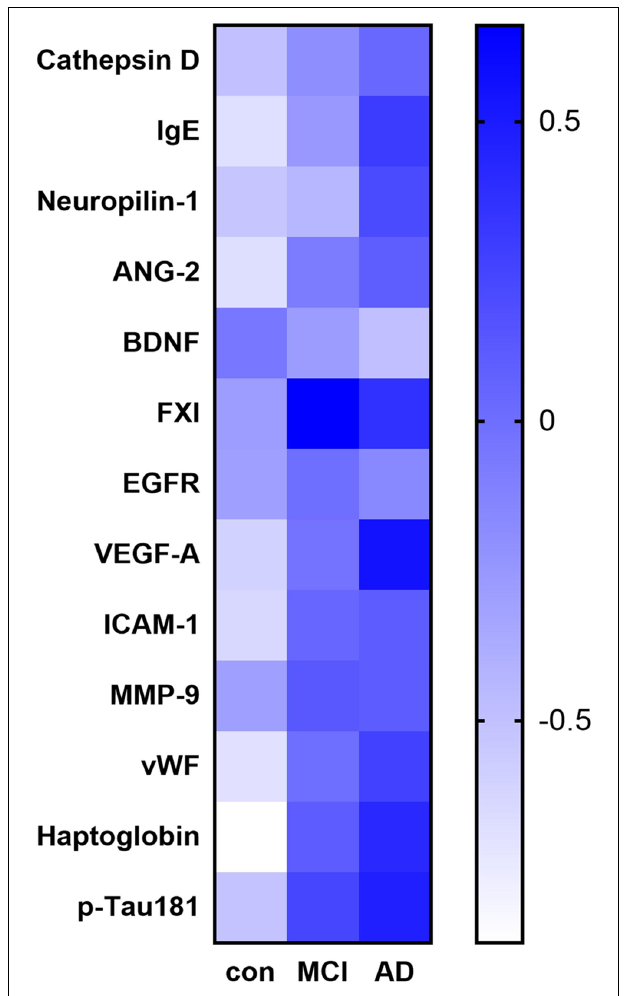
FIGURE 1 | Heat map of the identified potential biomarker proteins. The heatmap shows the overall expression of the 13 proteins with a significant difference in their serum levels (adjusted P < 0.05) between subjects with Alzheimer’s disease (AD) or mild cognitive impairment (MCI) and the